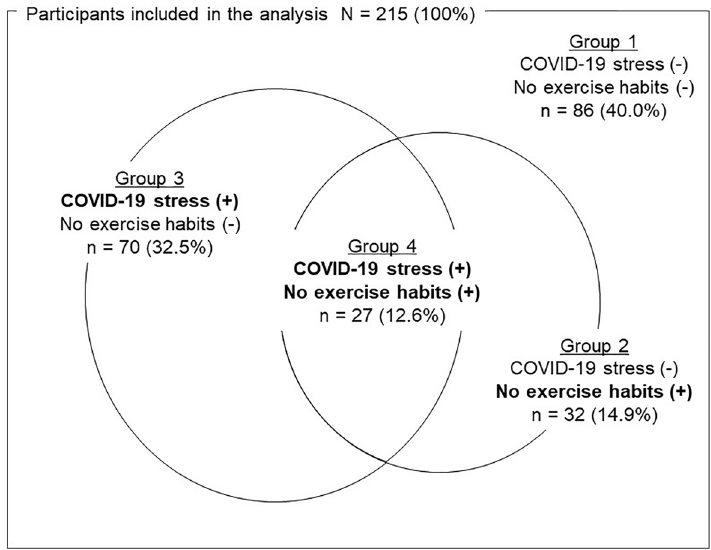
Figure 1. Classification of the four groups of risk of poor OHRQoL. The percentages of participants across the four groups according to the presence or absence of risk factors for poor OHRQoL are